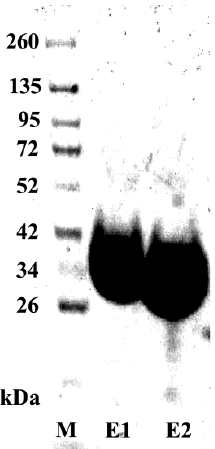
Figure 4. Determination of the purity of purified scFvH5. Purified scFv (2 µ g) was subjected to second